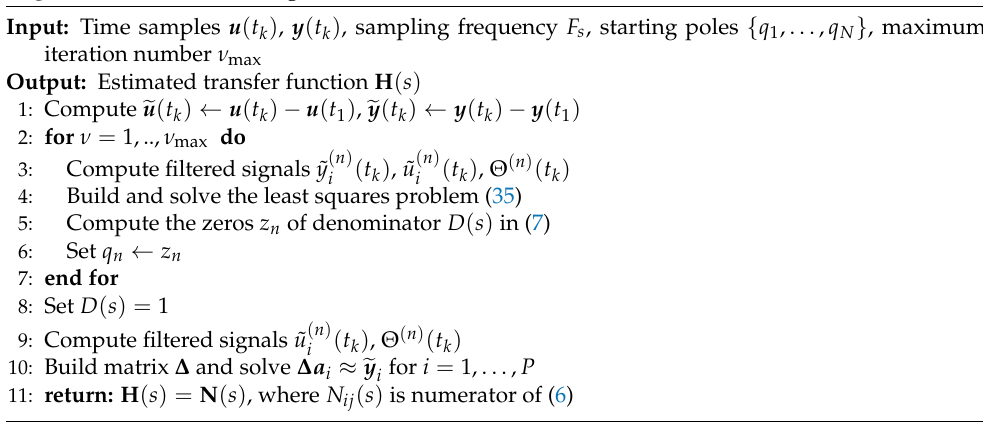
Algorithm 1. The final steps (lines 8–10) estimate the residues of a rational approximation